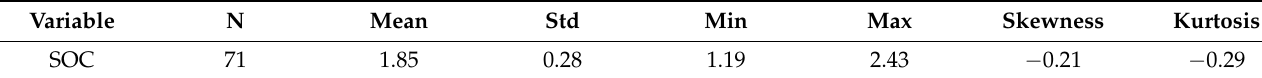
Table 1. Summary statistics for SOC (g 100 g − 1 ).